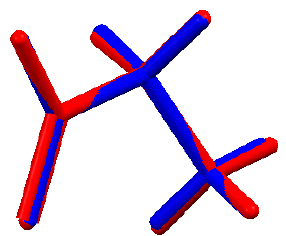
Figure 4. The structures determined by MOMS of α -glycine ( blue ) compared with the structure ( red ) obtained from single crystals. The root-mean-square deviation calculated for all atoms, including H atoms, was 0.0133 Å .